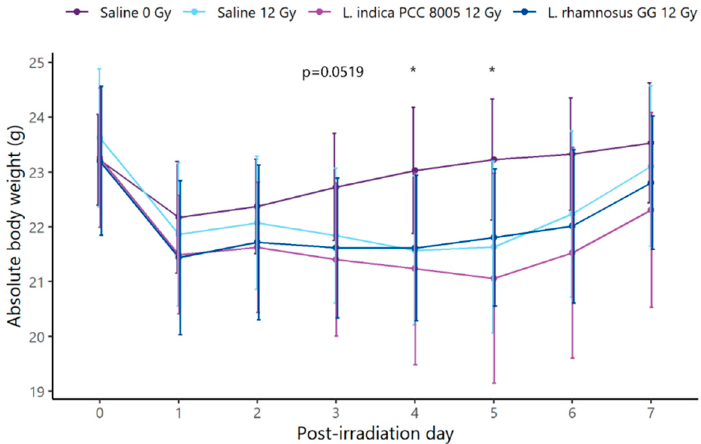
Figure 2. Curve of absolute body weight of all mice subdivided into four treatment groups: saline 0 Gy, saline 12 Gy, L. indica PCC 8005 12 Gy and L. rhamnosus GG 12 Gy. Data (in grams) are shown as means ± standard deviation, n = 10 per group. * p < 0.05 for pelvic irradiation-induced differences by linear modeling. Time-dependent differences in respect to the day of (sham-)irradiation (PID0) were not significant as assessed by linear mixed effects modeling.